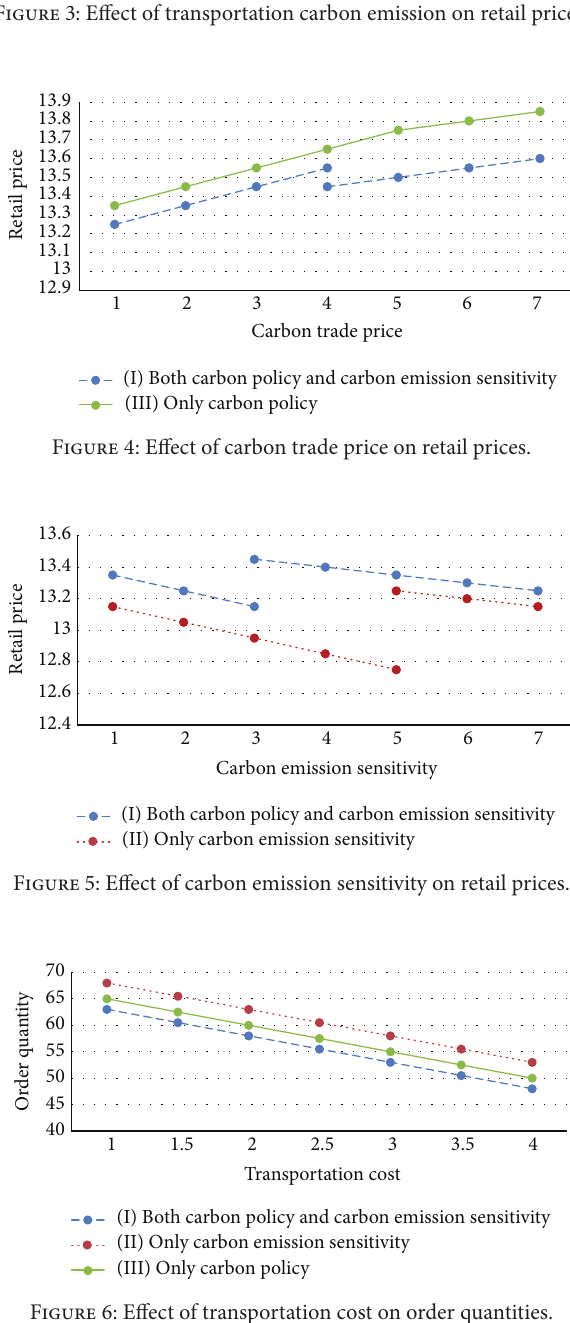
Figure 6: Effect of transportation cost on order quantities.